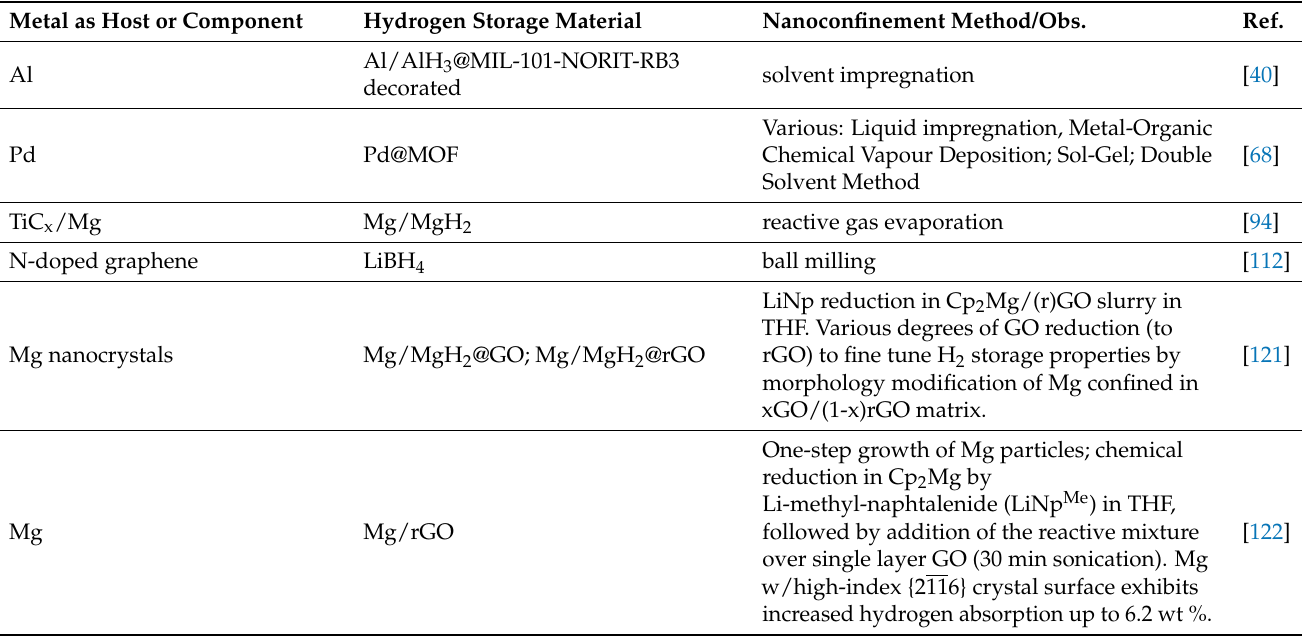
Table 5. Recent progress in oxides, sulfides and nitrides-based hosts for nanoconfined hydrogen storage